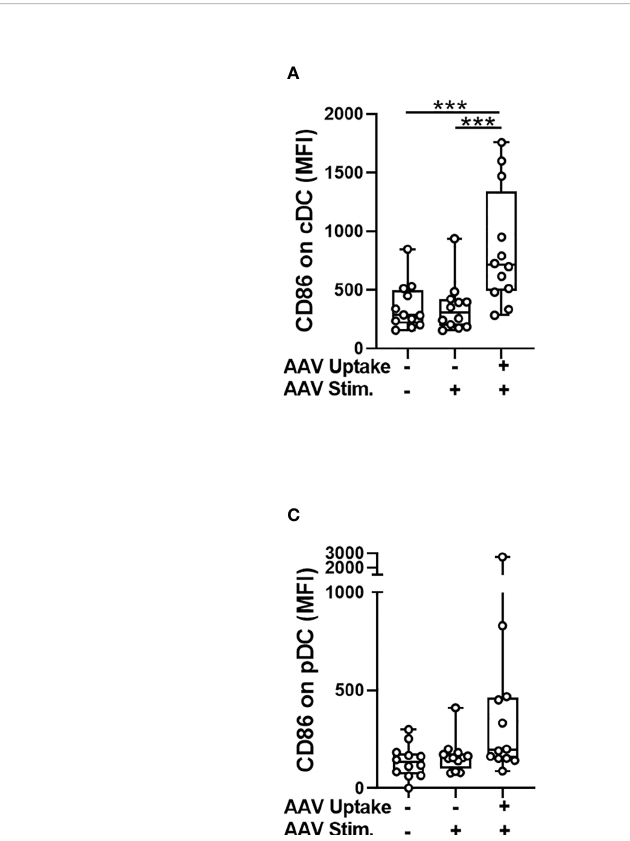
FIGURE 2 Activation of conventional dendritic cells (cDC) coincides with the AAV uptake. Whole blood from healthy human donors was stimulated with AAV-LK03 at 5×10 11 vg/mL for 24 hours and stained for intracellular AAV and phenotypic markers. Mean fl uorescence intensity (MFI) of CD86 staining is shown for (A) cDC, (B) moDC and (C) pDC. Symbols represent values of each donor. Signi fi cance was determined with One-way ANOVA with Tukey ’ s multiple comparisons test. *** p ≤